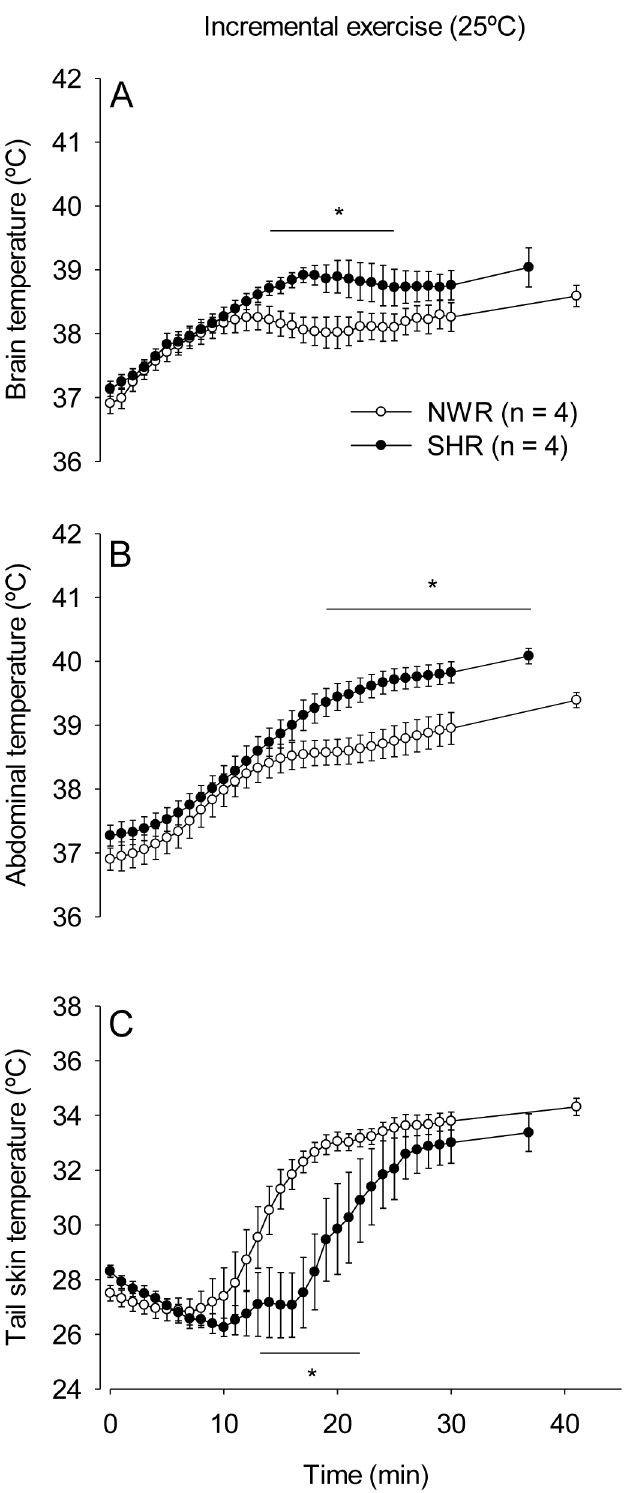
Fig 6. Exercise-induced thermoregulatory responses of rats from the two groups matched for body mass. (Body mass: NWR, 334 ± 10 g; and SHR, 346 ± 14 g; p = 0.528). Brain (panel A), abdominal (panel B) and tail skin (panel C) temperatures of the SHRs and NWRs subjected to incremental exercise in a temperate environment. Data are expressed as the mean ± S.E.M. * p < 0.05 compared with the NWR